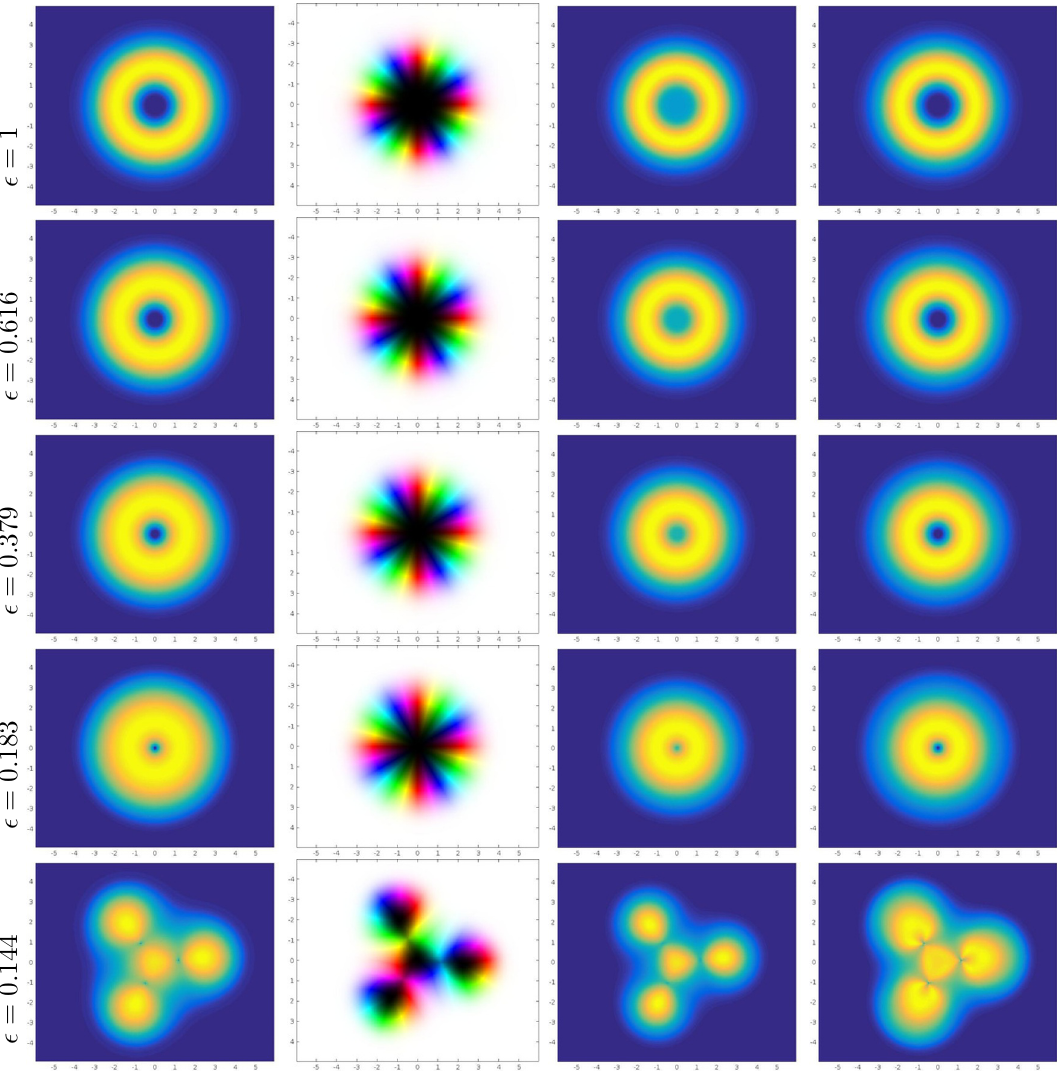
Figure 5 . The N = 4 baby Skyrmion solution as a function of (cid:15) . The columns display the topo- logical charge density, the field orientation using the color scheme described in the text, the total energy and finally the kinetic term − (cid:15) L 2 . The last row (i.e. for (cid:15) = 0 . 144 ) shows that the solution has decayed into a lower-energy state with tetrahedral symmetry instead of axial